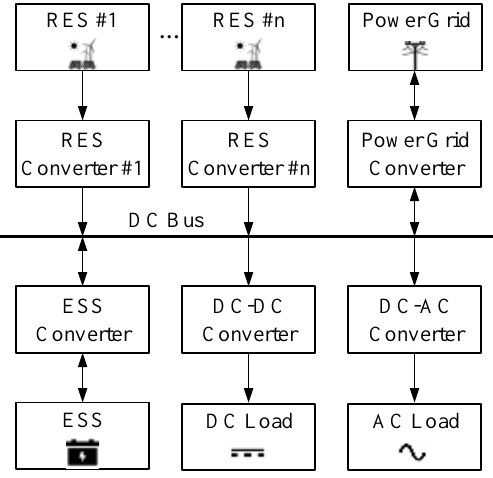
Fig. 1. Configuration of the alternative energetics DC